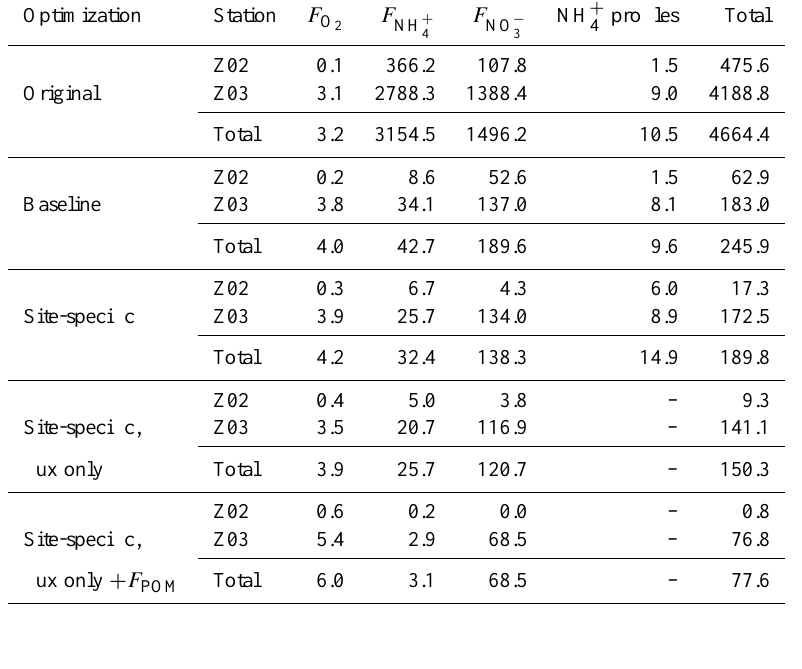
Table 3. Cost F(p) , calculated using Eq. (3), for each variable type at stations Z02 and Z03. Simulations were run with the parameter set from Soetaert et al. (1996a; original) and with the optimized parameter set (baseline). Additional optimizations were carried out for each station independently (site-specific), for each station using sediment–water fluxes only (site-specific, fluxes only), and including POM depositional flux in the optimization (site-specific, fluxes only, + F POM ) .